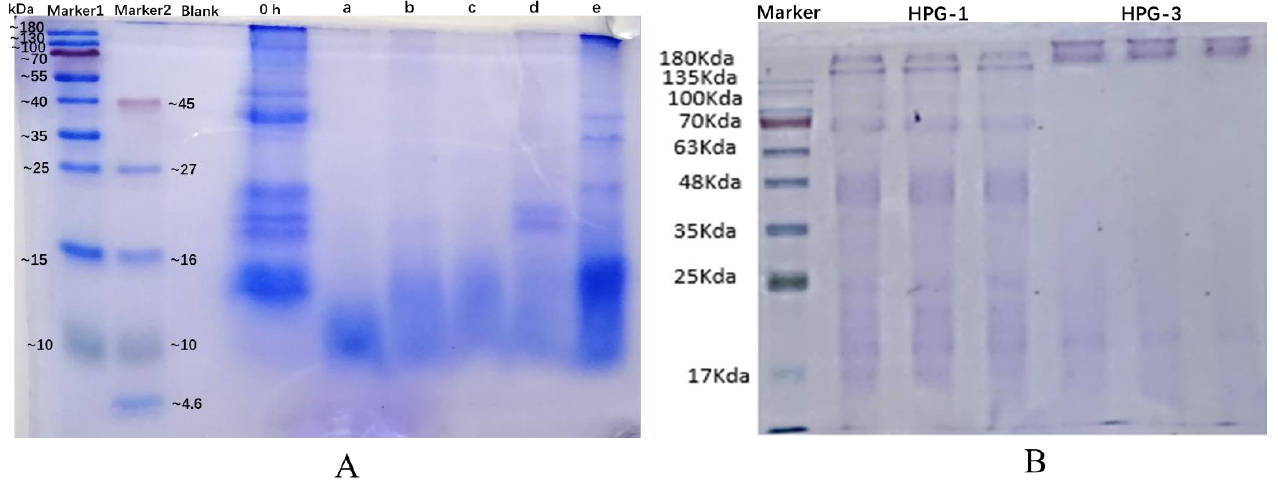
Figure 2. ( A ) Molecular weight determination of Hechong sample after enzymatic hydrolysis: without enzyme (0 h), and hydrolysates obtained in reaction time of 180 min with treatments of different enzymes: (a) alcalase, (b) trypsin, (c) papain, (d), neutrase, (e) pepsin. ( B ) The protein electrophoretogram of HGP-1 and HGP-3.